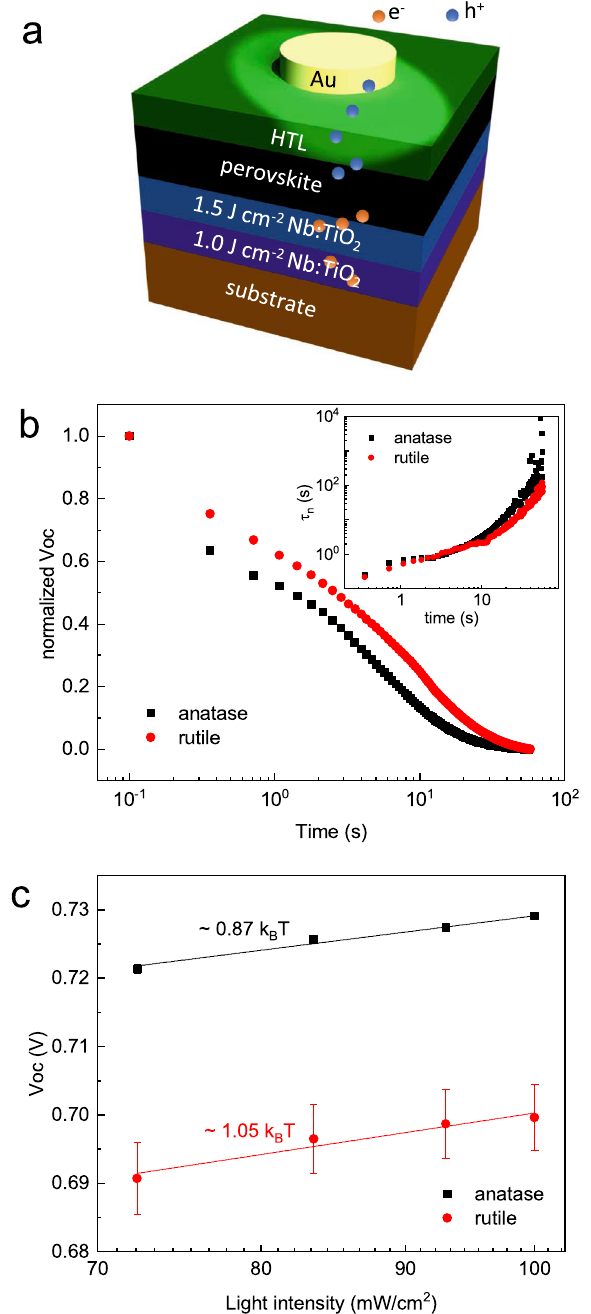
Figure 4. Electrical properties of the HPSC with different ETLs. ( a ) Schematic of the HPSC under illumination. ( b ) OCVD decay curves of the HPSC with different ETLs using the anatase or rutile phase on a semi-log scale. Inset of ( b ) shows the electron lifetime on a log–log scale from Eq. (2). ( c ) V OC as a function of the light intensity on a semi-log